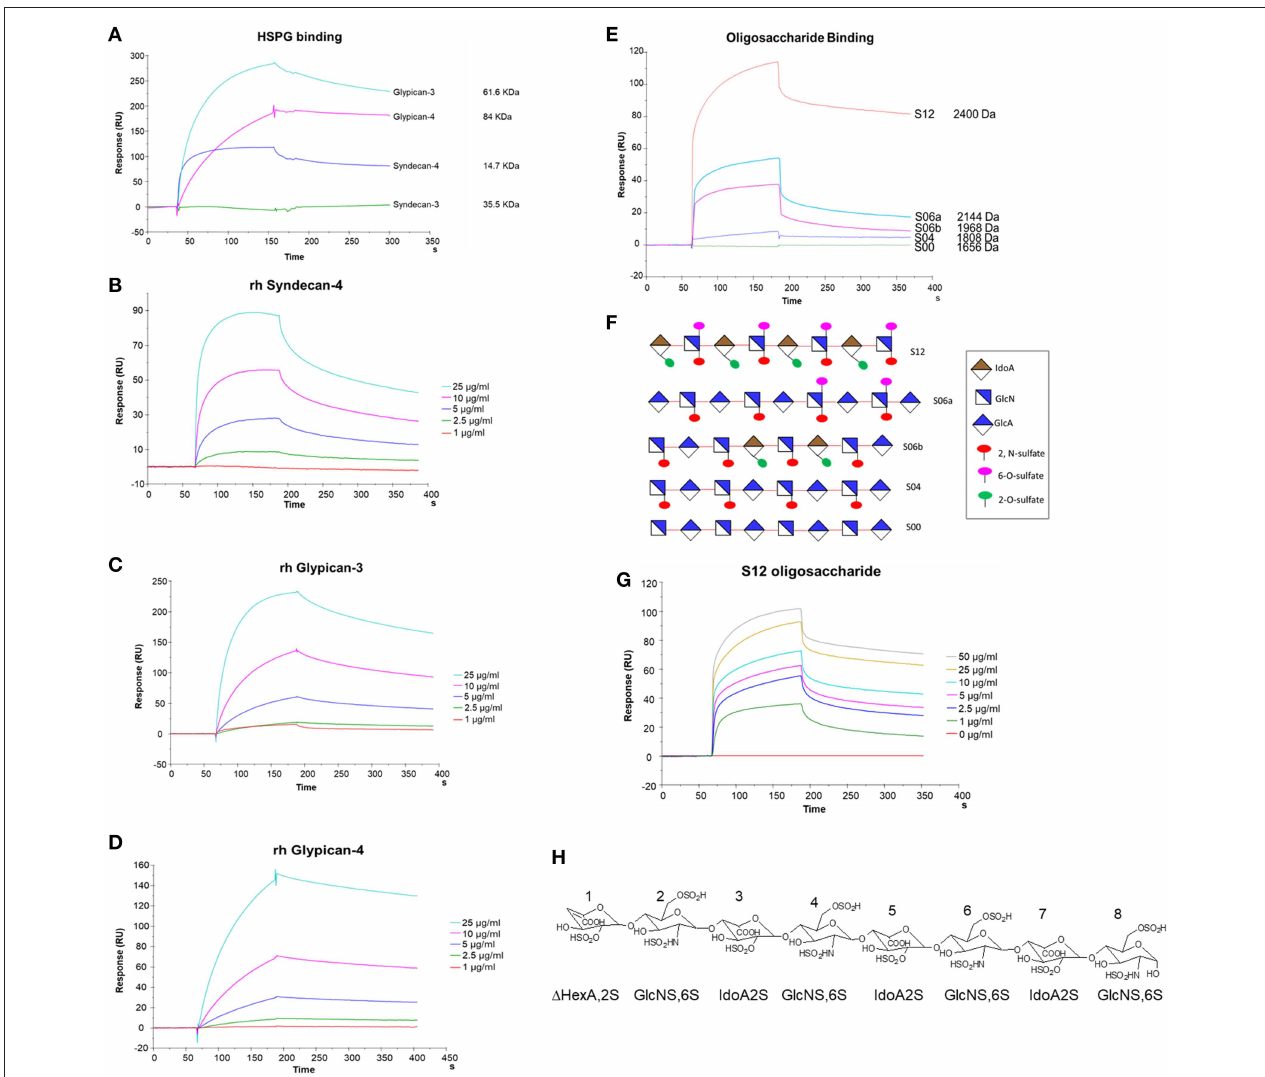
FIGURE 4 | SPR analysis of rHSPG and oligosaccharide binding to NT4. (A) rHSPG binding (25 µ g/mL) to immobilized NT4. (B–D) Affinity of rHSPG for NT4. (E) Oligosaccharide (100 µ g/ml) binding to surface immobilized NT4. (F) Schematic representation of oligosaccharides with sulfation sites. (G) Affinity of S12 sulfated oligosaccharide binding to NT4. (H) Structure of